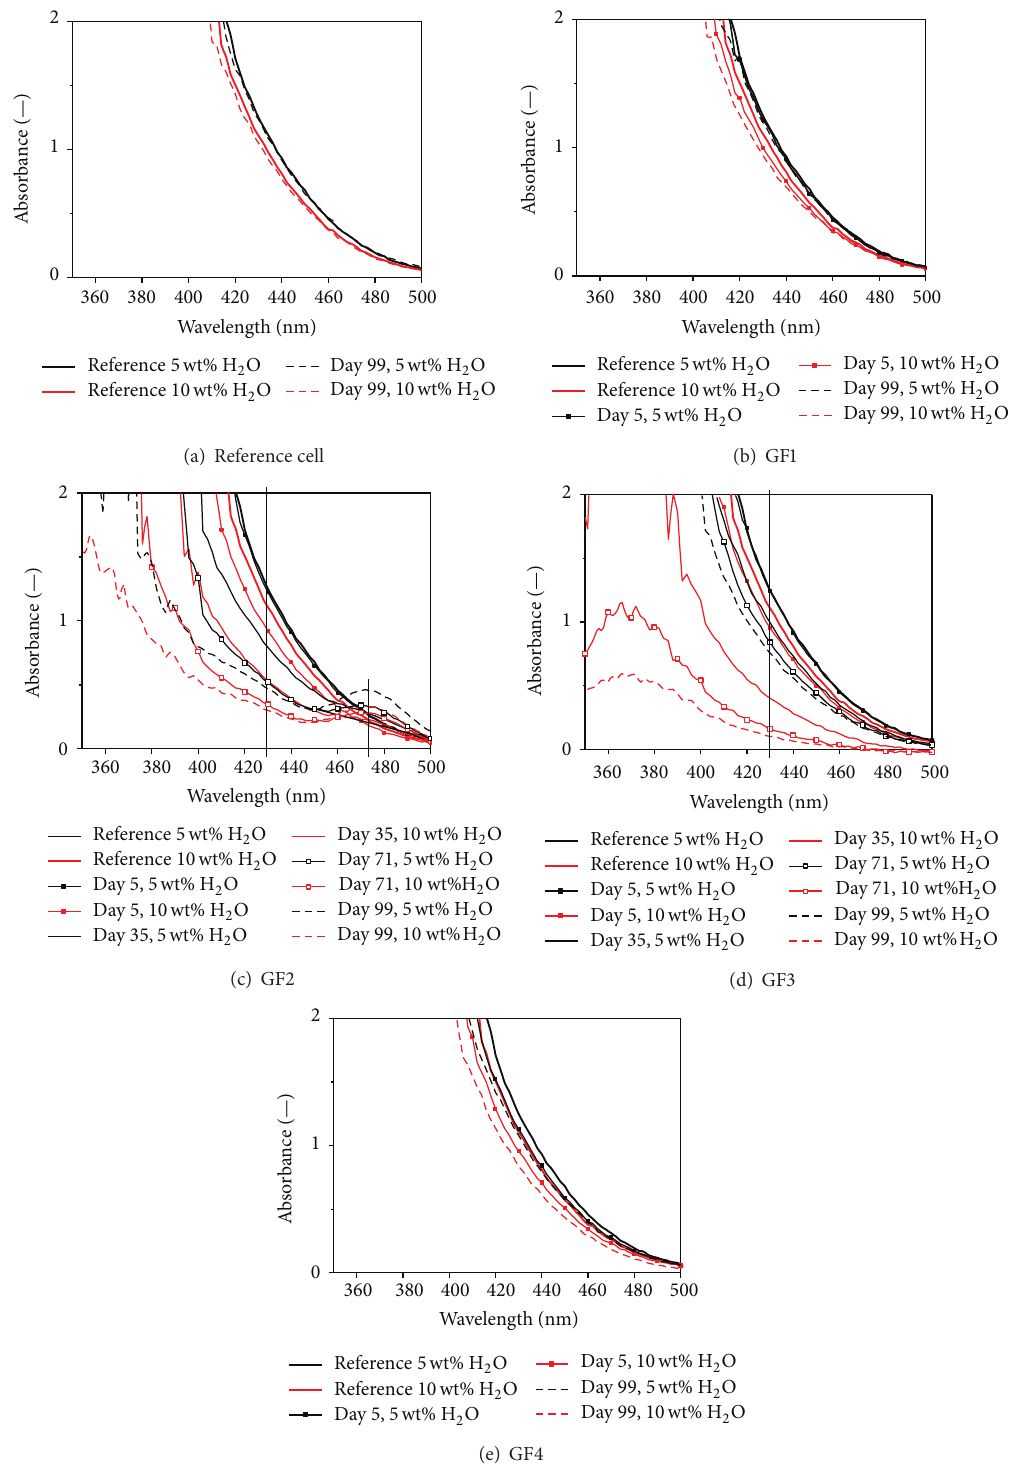
Figure 4: Development of absorbance spectra during ageing of the reference cell (no GF) and the test cells with 5 and 10wt% H 2 O added to the redox electrolyte. (a) Reference cell with no GF; no change in absorbance over time, (b) test cell with GF1 showing stable absorbance spectra over time, (c) test cell with GF2; notice the appearance of a new peak at 475 nm and the decrease in absorbance at lower wavelengths, (d) test cell with GF3 showing continuous decrease in absorbance over time, and (e) test cell with GF4 which is relatively stable over